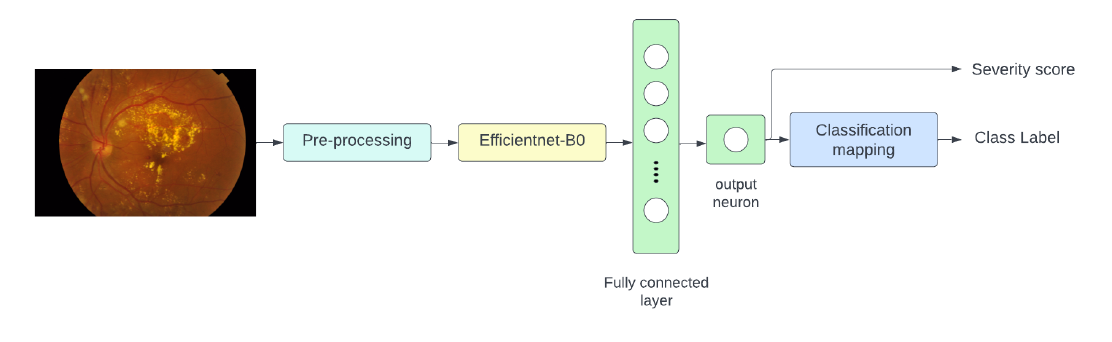
Figure 3. Overall